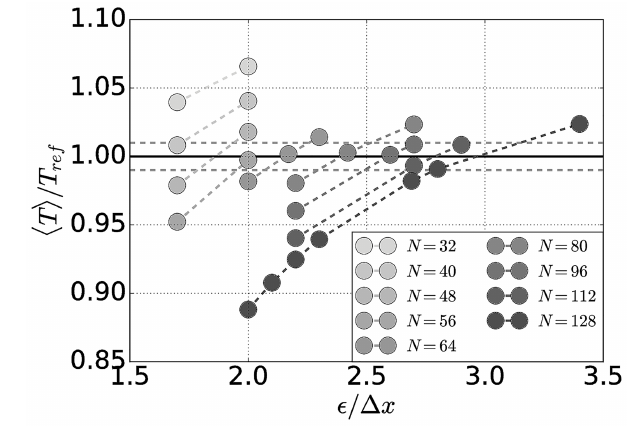
Figure 6. Relation between (cid:15)/(cid:49)x and the resulting global torque normalized by the reference torque for U ∞ = 15ms − 1 .